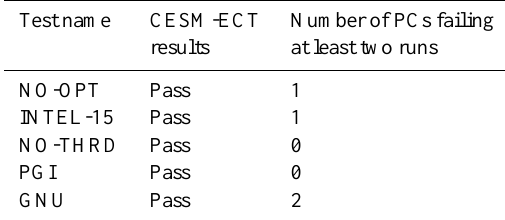
Table 2. CESM modifications expected to produce the same cli-